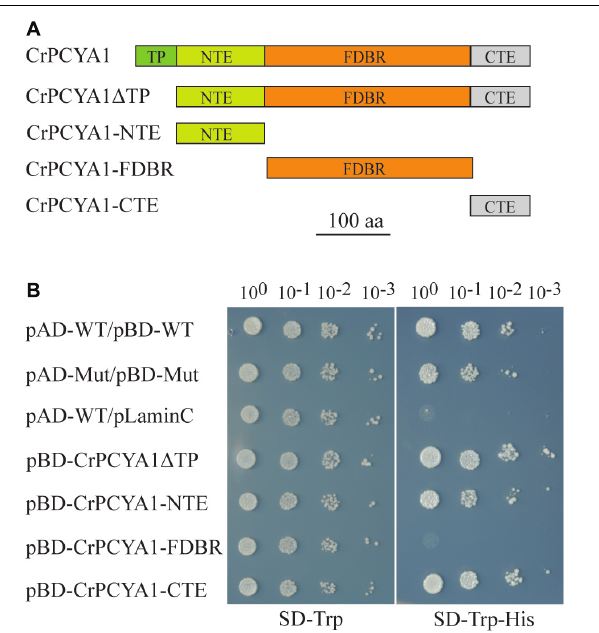
FIGURE 1 | Autoactivation activity test of Chlamydomonas CrPCYA1 protein in yeast. (A) Illustration of CrPCYA1 domains and CrPCYA1 truncated proteins used as baits for yeast two hybrid experiment. TP, putative chloroplast transit peptide; NTE, N-terminal extension; FDBR, ferredoxin-dependent biliverdin reductase; CTE, C-terminal extension. (B) Growth of yeast cells on synthetic dropout (SD) plates. The coding regions of CrPCYA1 truncated proteins were ligated into pBD-GAL4 vector and transformed into YRG2 yeast strain. Yeast cells were spotted onto SD-Trp and SD-Trp-His agar plates with 10-fold serial dilutions. pAD-WT/pBD-WT and pAD-Mut/pBD-Mut were used as positive controls, and pAD-WT/pLaminC was used as a negative control. WT,